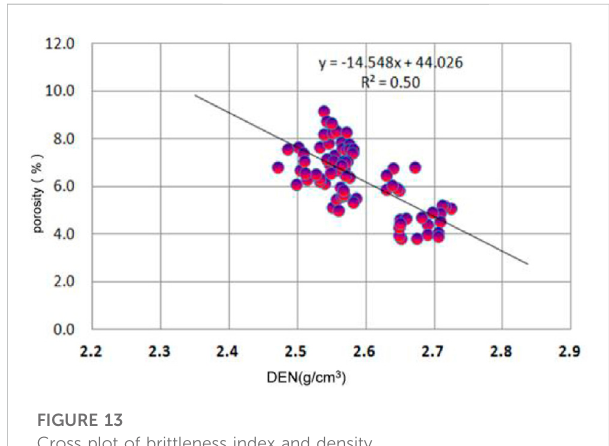
FIGURE 13 Cross plot of brittleness index and density.